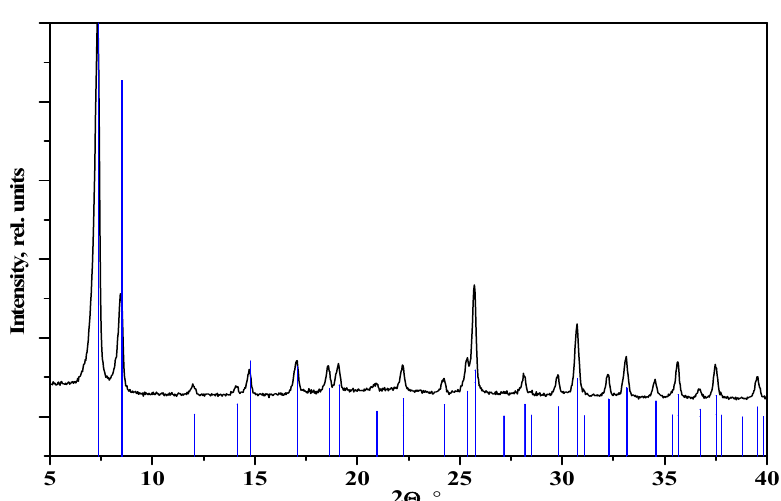
Figure 2. PXRD pattern of synthesized UiO-66; vertical markers—calculated positions of Bragg reflections of UiO-66.